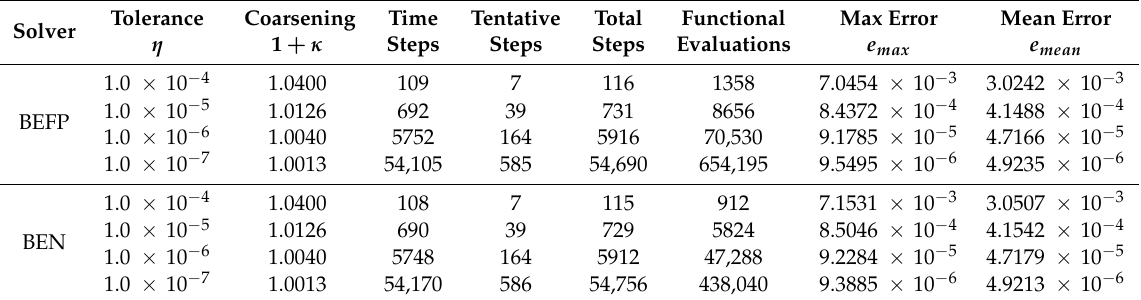
Table 2. Shifted linear iterative splitting method for Bernoulli’s